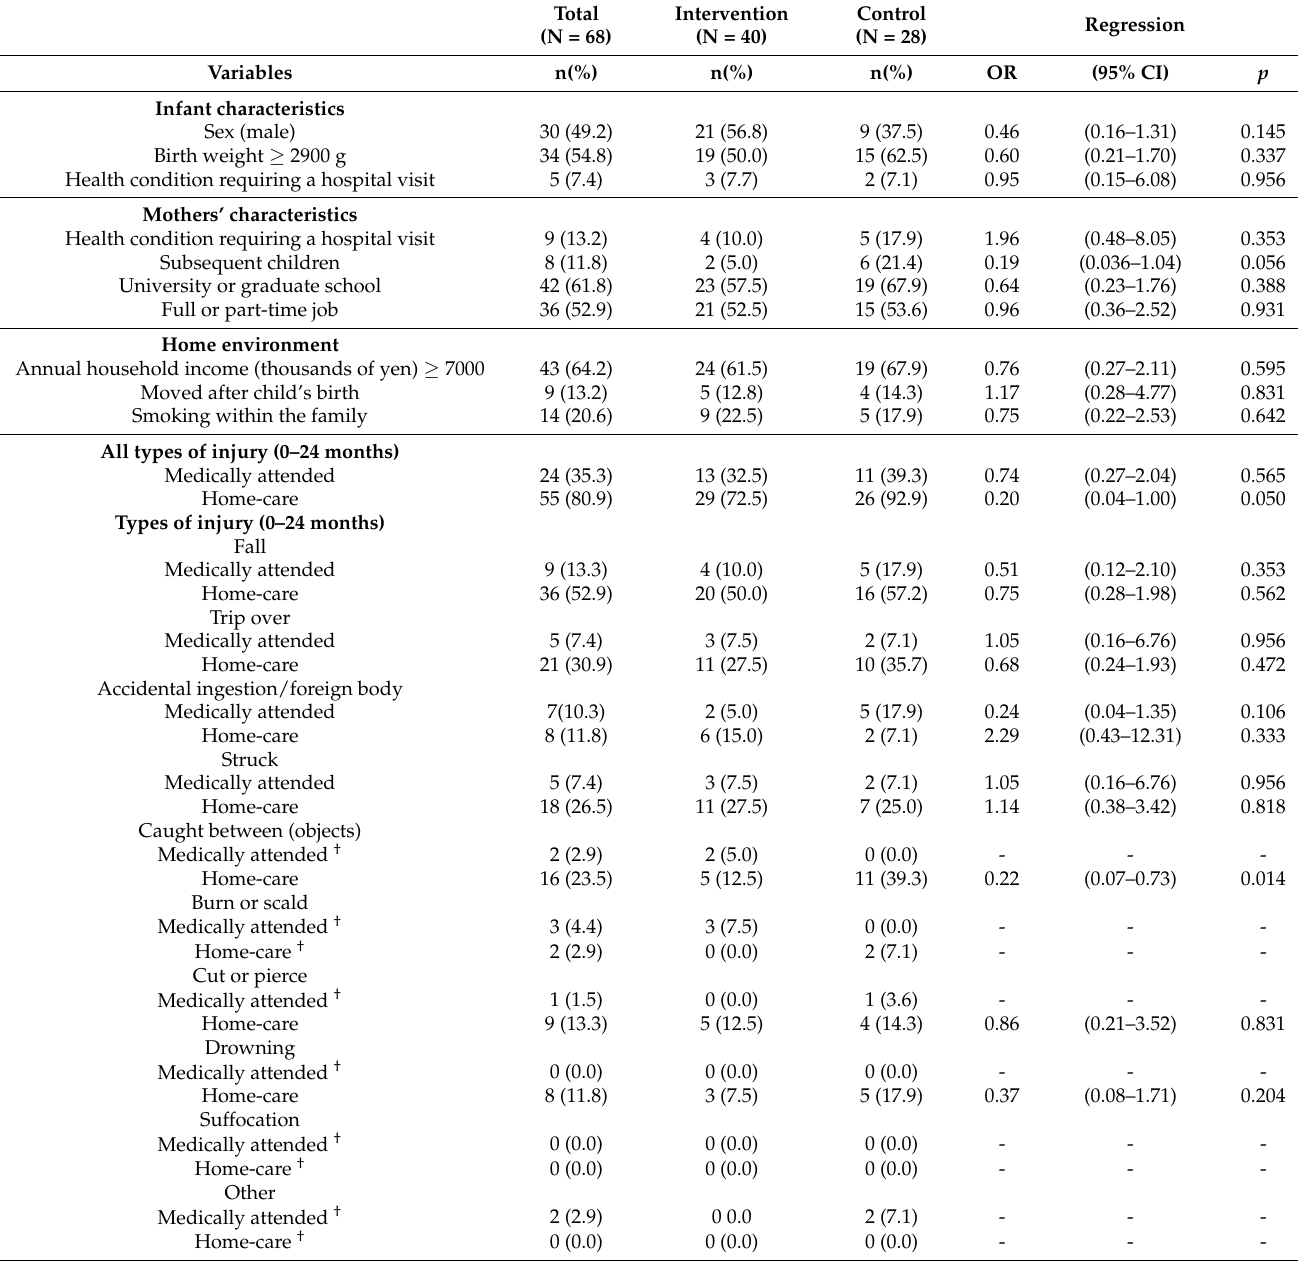
The participant characteristics were not significantly different between the groups (Table 1). The average birth weight was 2987 g, and 49.2% of participants had male children. More than half of the mothers had a college or higher education (61.8%), and 52.9% had full- time or part-time jobs. Over half (64.2%) of the participants reported an annual household income of ≥ 7 million yen. Table 1. Participant